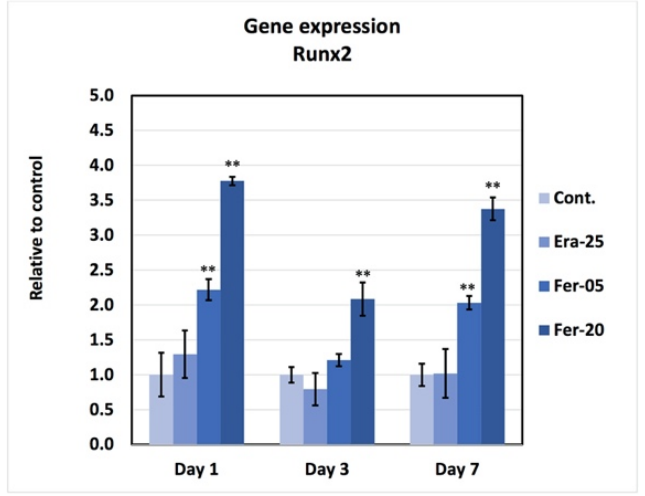
Figure 9. The gene expression of RUNX2 after exposure to Era-25, Fer-0, Fer-05, and Fer-20 for 1, 3, and 7 days culture with normalized data to GAPDH. (** p < 0.001).